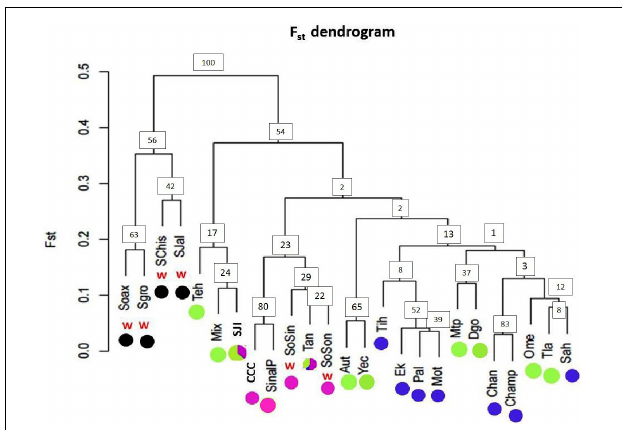
FIGURE 7 | Pairwise F ST dendrogram for 19 argyrosperma populations and 6 sororia populations. Populations of the wild subspecies ( sororia ) are indicated (w). Dot colors agree with the pie graphs corresponding to the proportion of individuals per population assigned to each genetic cluster obtained with STRUCTURE for K = 4 shown in Figure 6 . Population ID is shown in Table 1 . Node values represent bootstrap support.